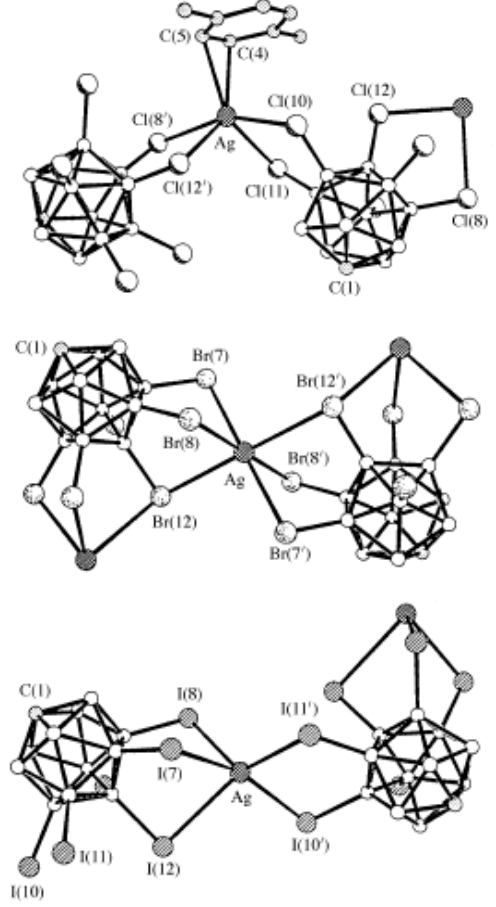
Figure 67. Fragments of X-ray structure of {Ag( η 2 - para -xylene)[1-CB 11 H 6 -6,7,8,9,10,11,12-Cl 6 ]} n ( a ), {Ag[1-CB 11 H 6 -6,7,8,9,10,11,12-Br 6 ]} n ( b ) and {Ag[1-CB 11 H 6 -6,7,8,9,10,11,12-I 6 ]·0.5(benzene)} n ( c ). Reproduced from reference [95] with permission from The Royal Society of Chemistry.